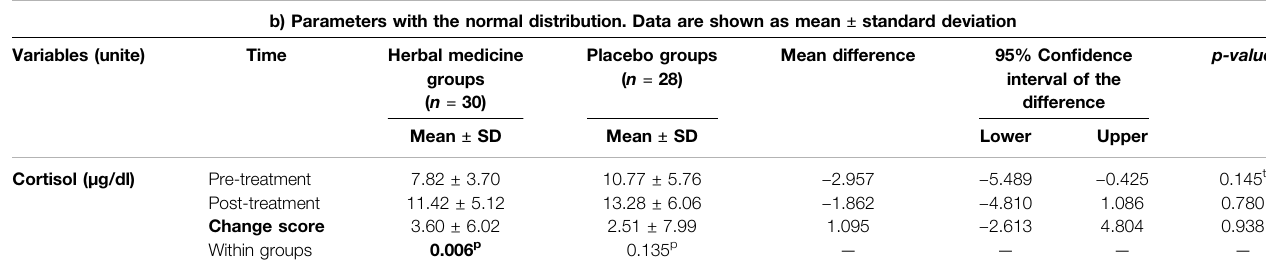
Between-group p -values show the signi fi cance of differences in the studied parameters between two study groups before and after the trial period. Within-group p -values show the signi fi cance of differences in the studied parameters of each study group before and after the trial period. Change score p -values compare between p -values of each studied parameter. t, T-test; tt, Mann-Whitney test; w, Wilcoxon test; p , Pair t-test. Bold fi gures show that the difference is signi fi cant ( p < 0.05).